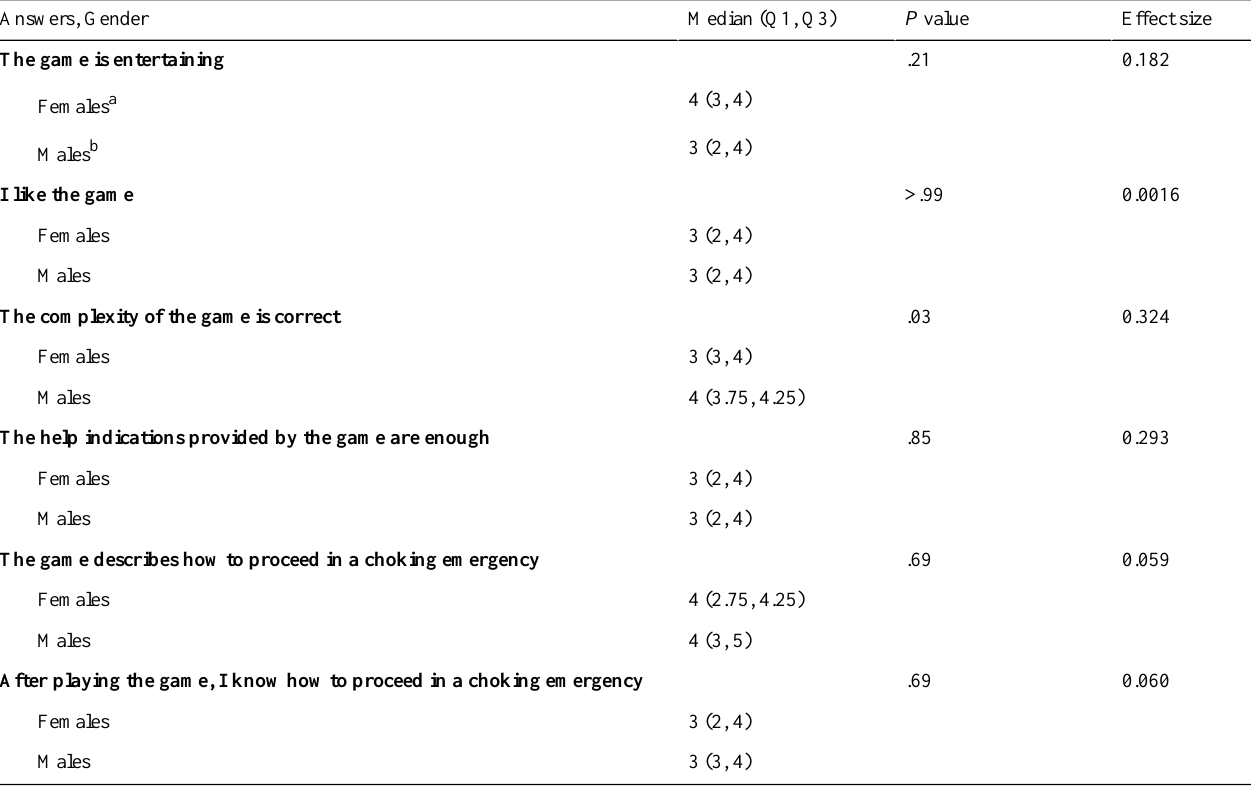
Table 2. Descriptive statistics of the answers to the questions related to the game (grades 1-5) by each